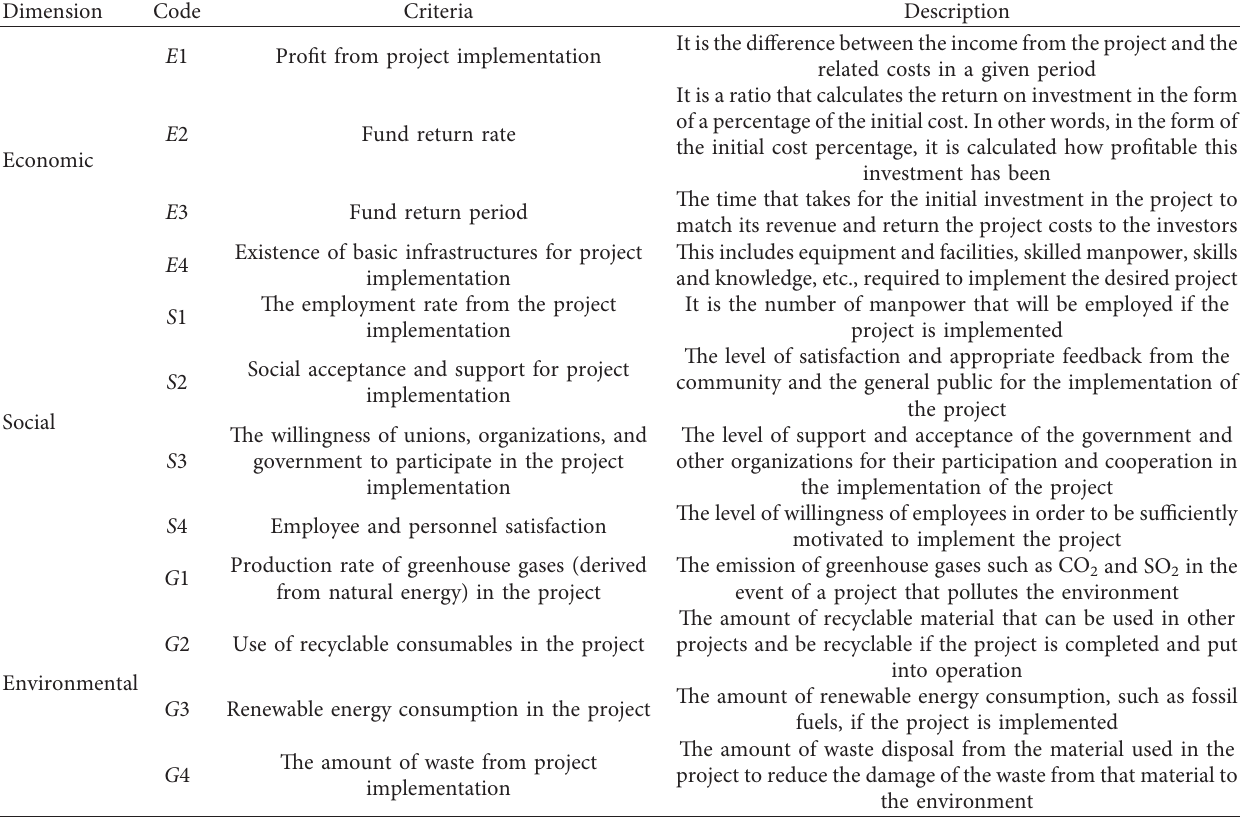
Table 8: Filtering of sustainability